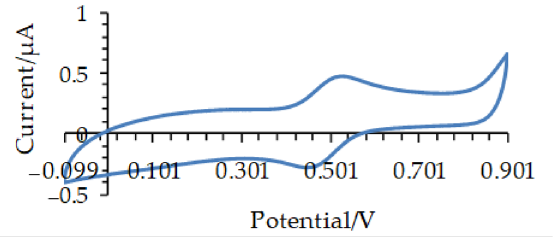
Figure 2. Typical cyclic voltammogram (electric current versus potential) of 0.1 mM ABTS in 1 mM CH 3 COOH and 10 mM KCl at the scan rate of 10 mV/s, with the anodic (Ip,a) and cathodic (Ip,c) peaks in reversible electrochemical